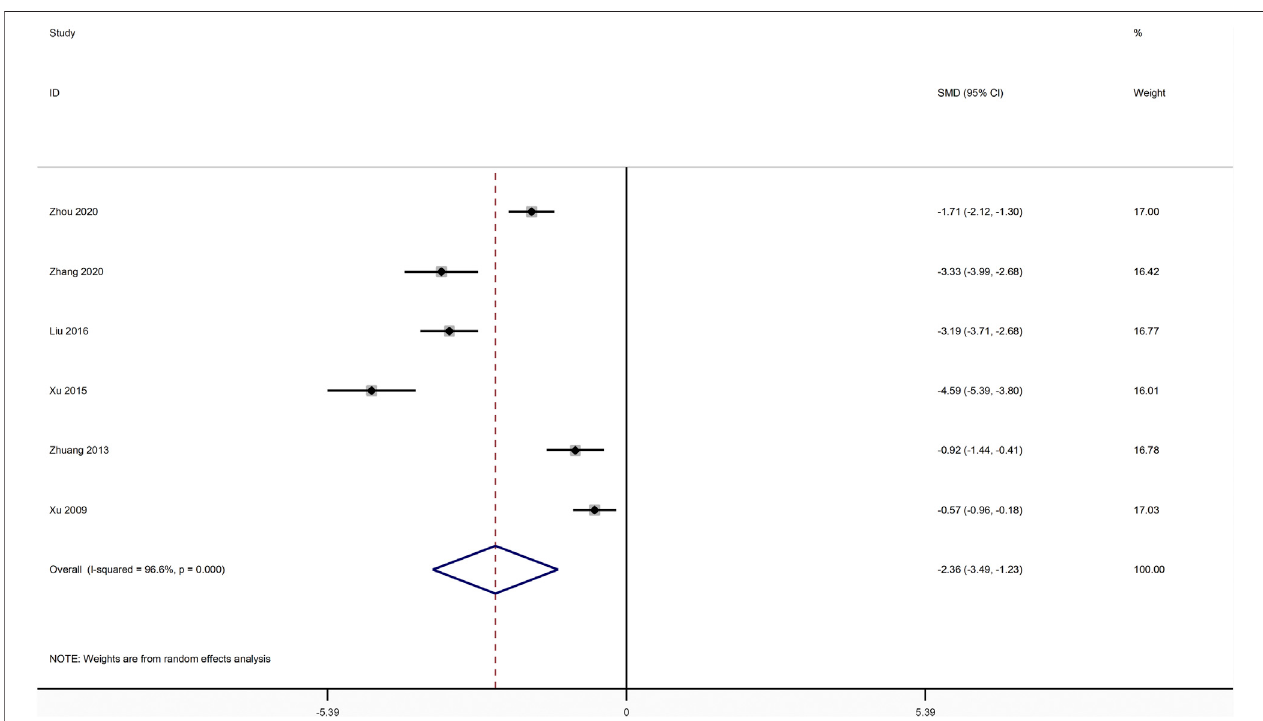
FIGURE 5 | Forest plot of XLGB combined with ALE vs. ALE alone with regard to